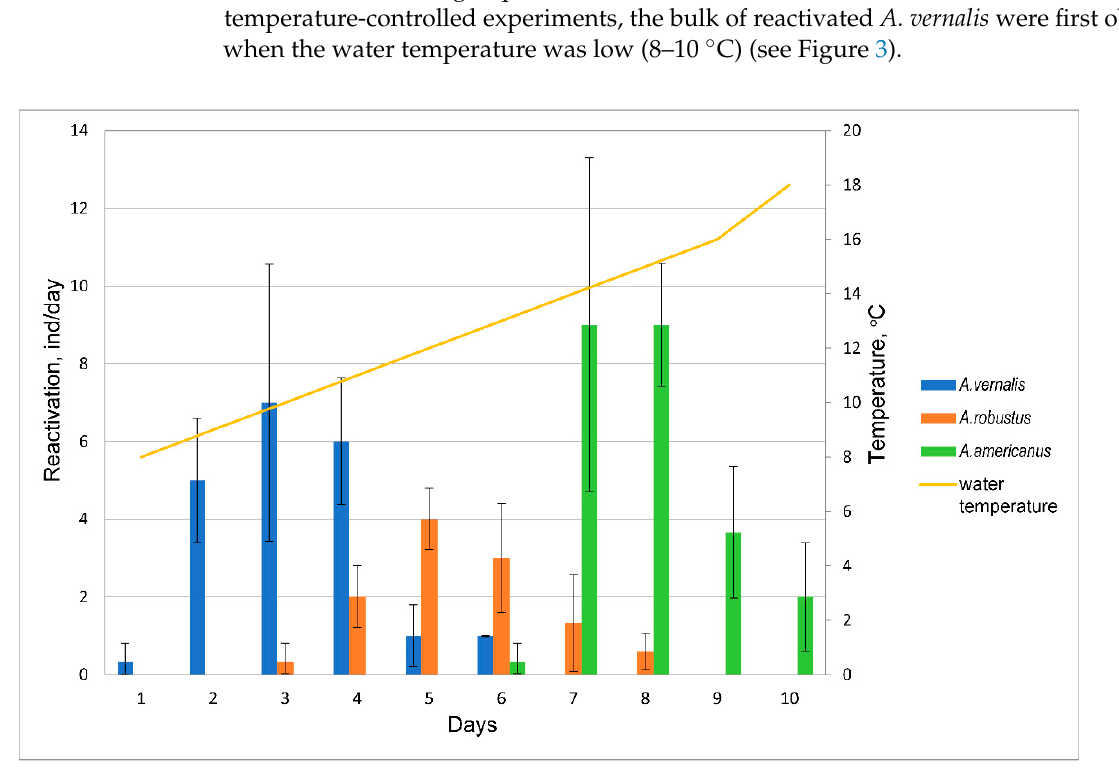
Figure 3. Dependence of the reactivation rate on temperature in Acanthocyclops vernalis , Acanthocyclops americanus and Acanthocyclops robustus .